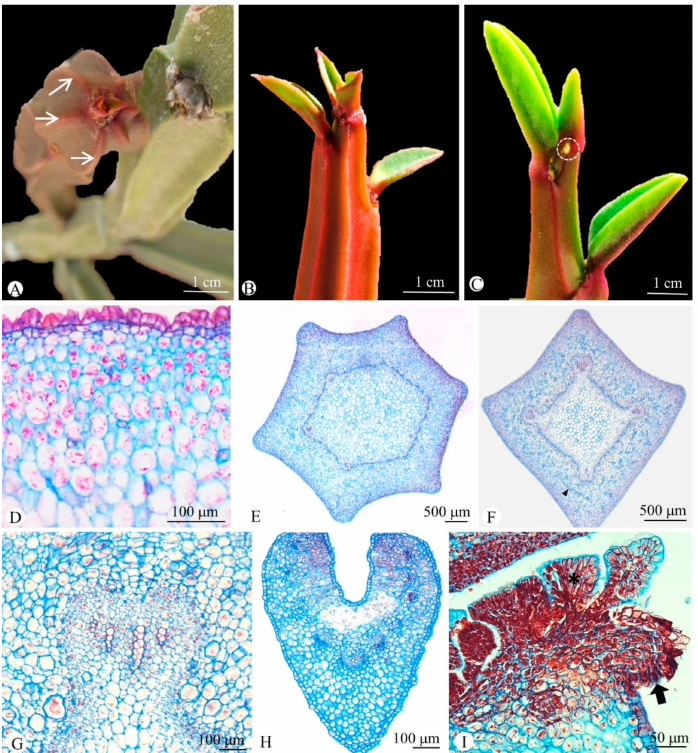
Figure 1. Stem morphology and anatomy of Euphorbia attastoma ( A , B , D , E ) and E. tetrangularis ( C , F – I ). Cross sections ( D , E , F – I ). ( A ) Stem ribs in frontal view (arrows) with leaves restricted to the shoot apex. ( B , C ) Note the spiral leaves in ( B ) and alternate, distichous leaves with stipules in the leaf base (dashed circle) in ( C ). ( D ) Detail of a rib showing many layers of chlorenchyma and a papillate epidermis. ( E , F ) Stem with a prominent vascular bundle in the eustele in each radius of the ribs, numbering six in E. attastoma ( E ) and four in E. tetrangularis ( F ). Note the numerous branched laticifers (arrowhead in ( F )). ( G ) Detail of a vascular bundle of the eustele. ( H ) Median portion of the leaf with chlorenchyma and vascular bundles. ( I ) Detail of the leaf axil with colleters (asterisk) and one of the glomeriform stipules